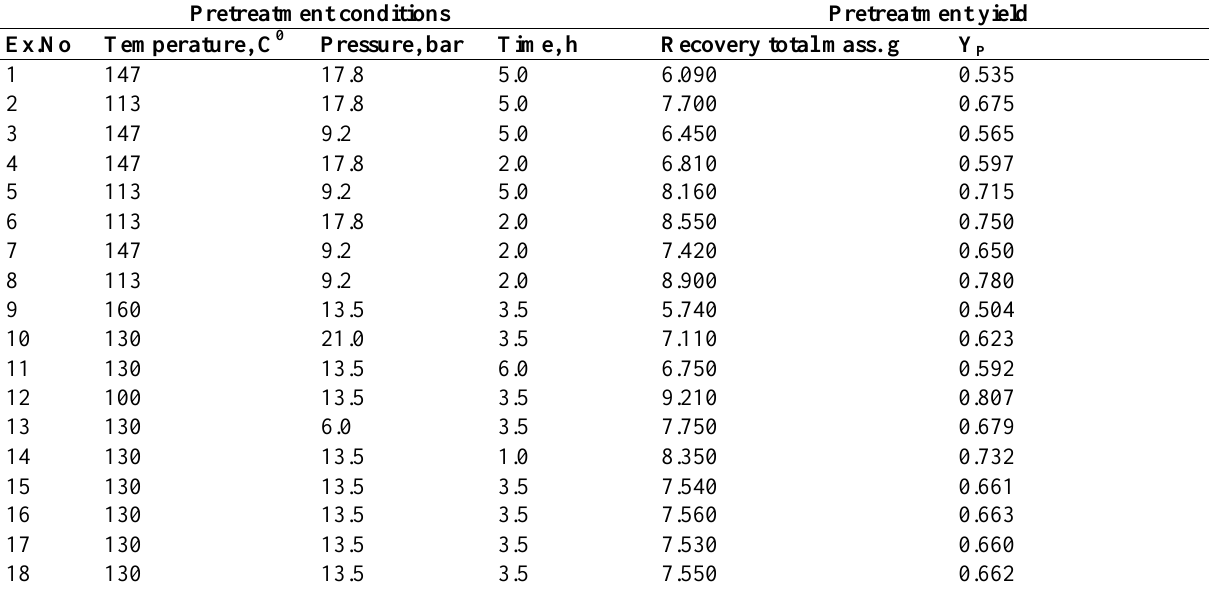
Pretreatment yield of total mass with pretreatment conditions . Pretreatment conditions